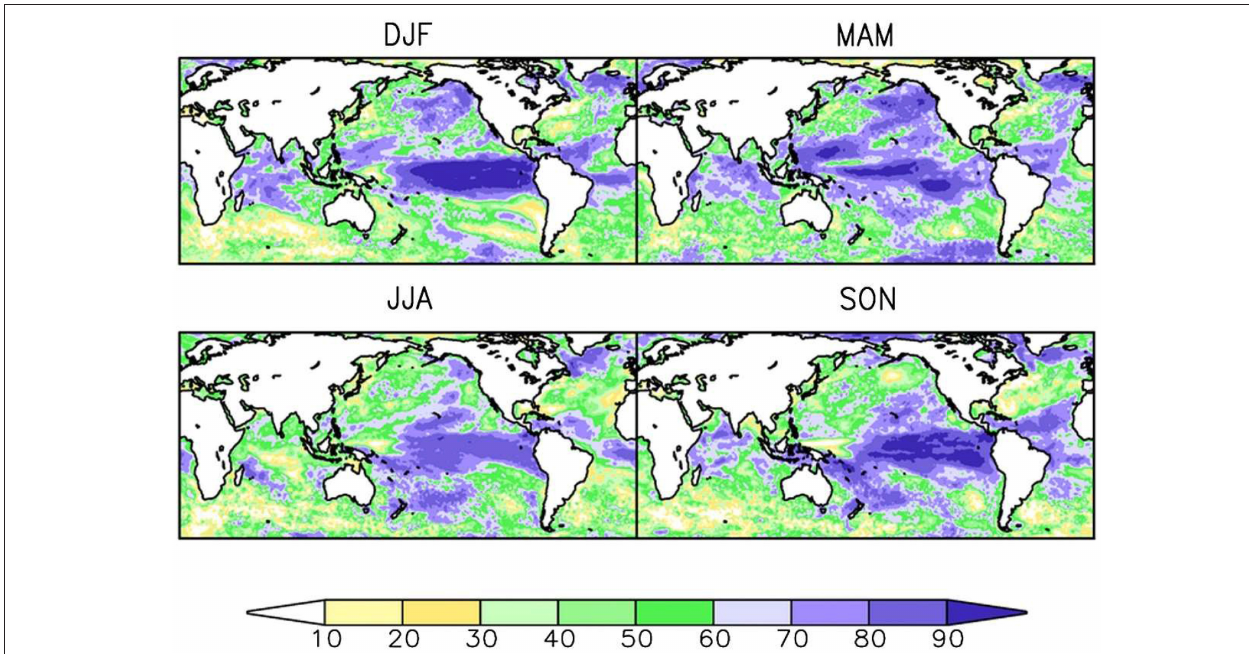
FIGURE 2 | Seasonal-scale sea surface temperature (SST) forecast skill. Skill is shown here for the North American Multi-model Ensemble (NMME) as the correlation coefficient (as a percentage) between observed and forecast seasonal anomalies for a 1 month forecast lead time. Correlation coefficients are shown for temperature anomalies averaged over each of four seasons. Top-left : December, January, February (DJF). Top-right : March, April, May (MAM). Bottom-left : June, July, August (JJA). Bottom-right : September, October, November (SON). Modified from (Becker et al., 2014). © 2014 American Meteorological Society. Used with